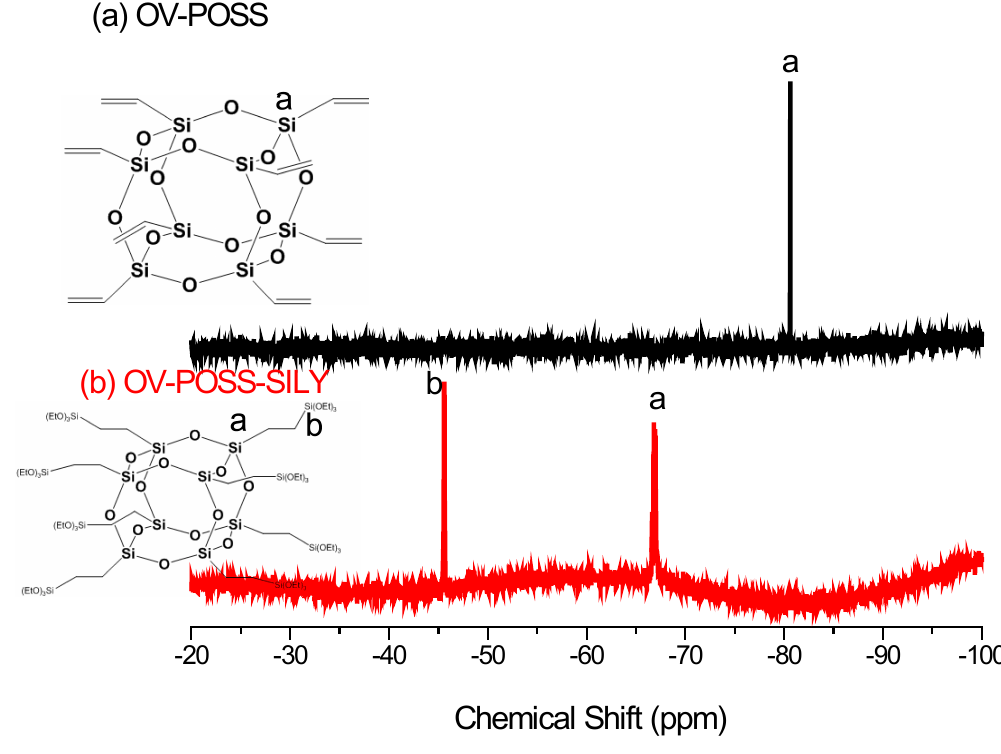
Figure 3. 29 Si NMR spectra of OVPOSS and